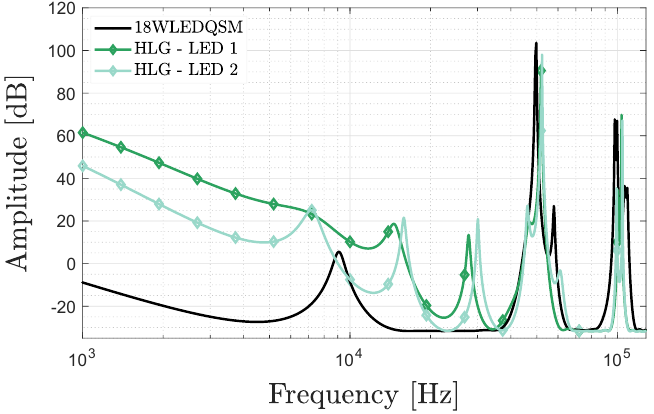
Figure 3. MUSIC pseudospectrum versus frequency of the 18WLEDQSM LED panel (black curve) and for a single HLG-40H-48A module driving two different BXRE chip on board (COB) LEDs (in green).